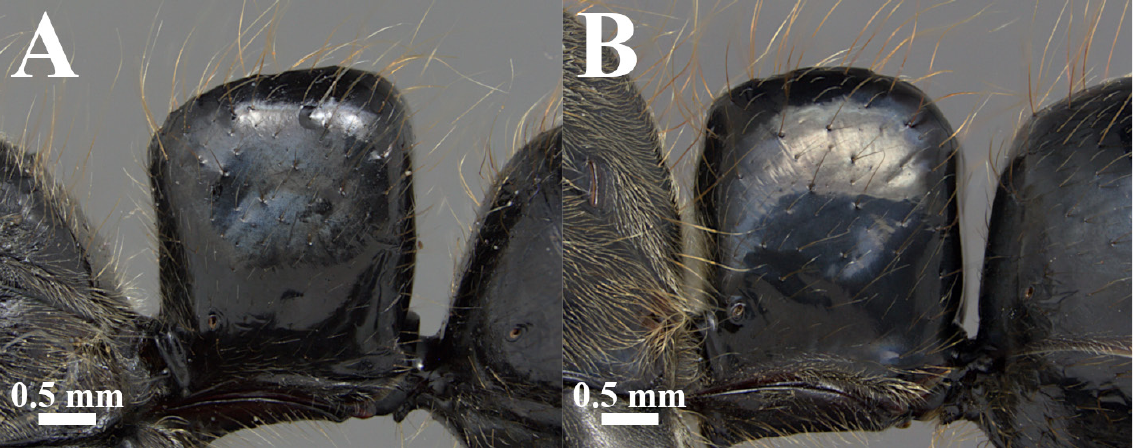
Fig. 4. Petiolar node in lateral view. A . Dinoponera lucida Emery, 1901. B . D . nicinha sp.